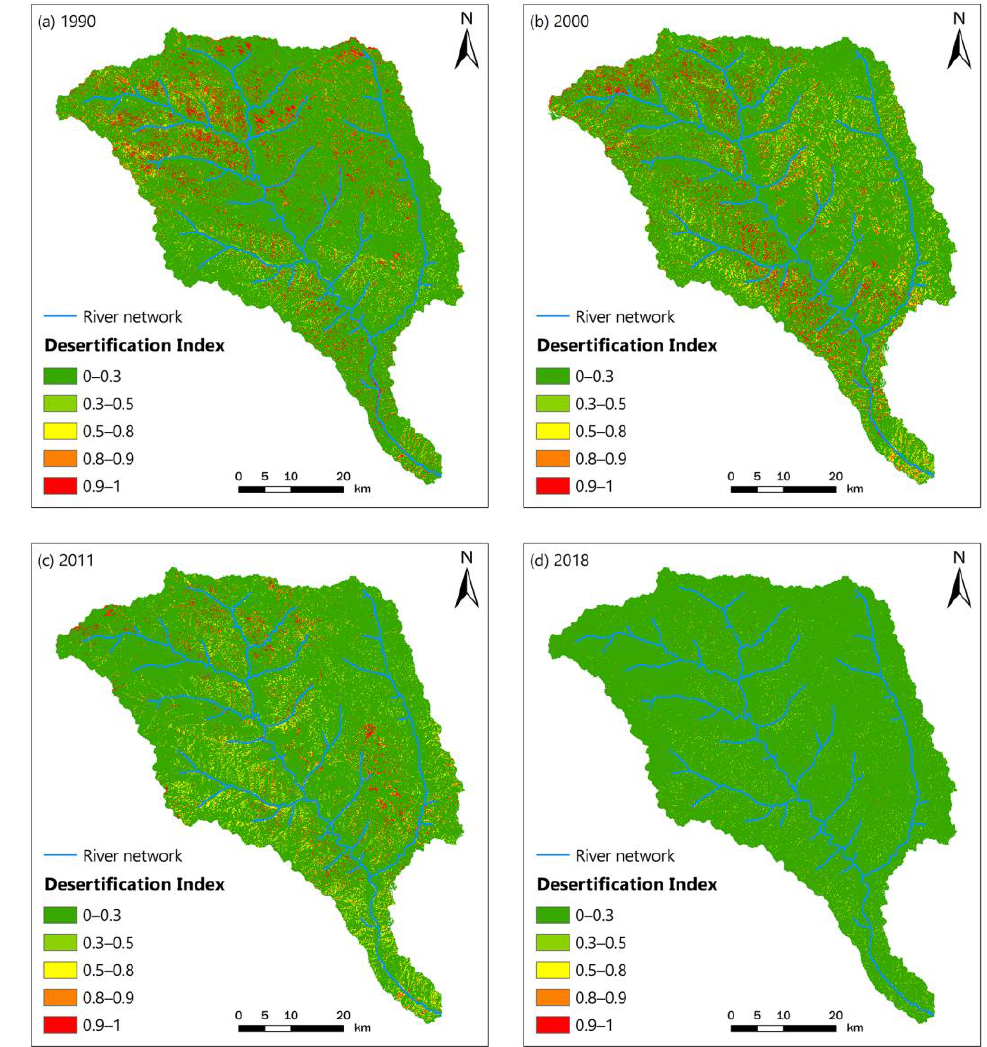
Figure 3. Desertification index changes in the Huangfuchuan watershed. ( a ) Desertification index map in 1990. ( b ) Desertification index map in 2000. ( c ) Desertification index map in 2011. ( d ) Desertification index map in 2018.